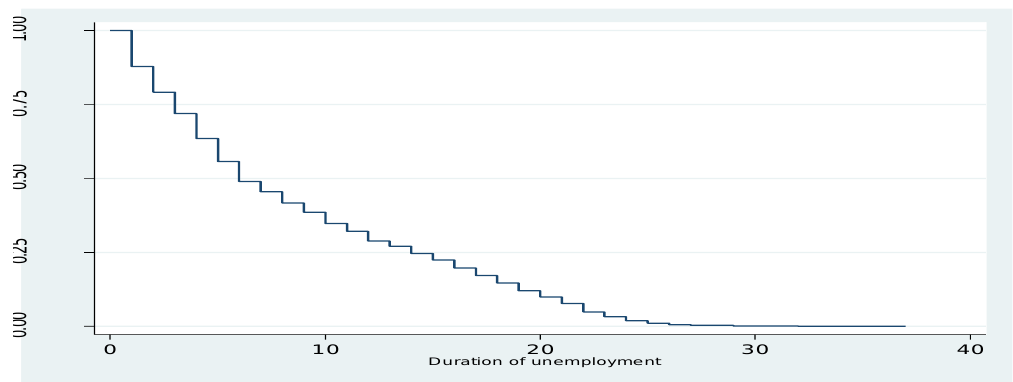
Figure 15: Survival function estimates for all unemployed